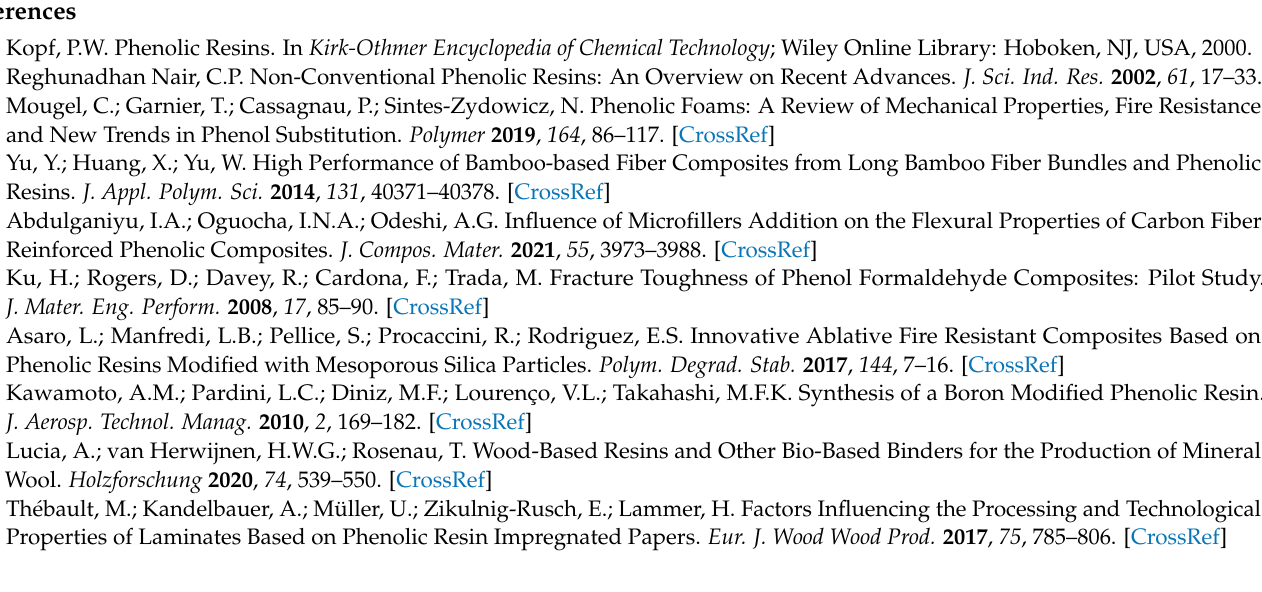
Figure S3: Normalized FTIR spectra of phenolic